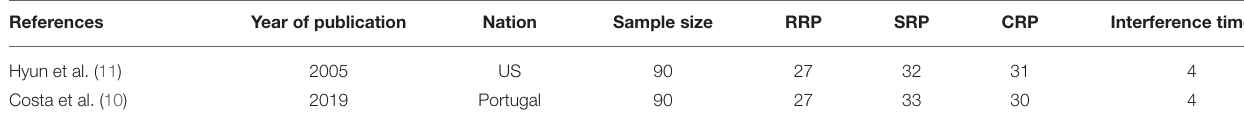
TABLE 1 | Basic information of the eligible studies.